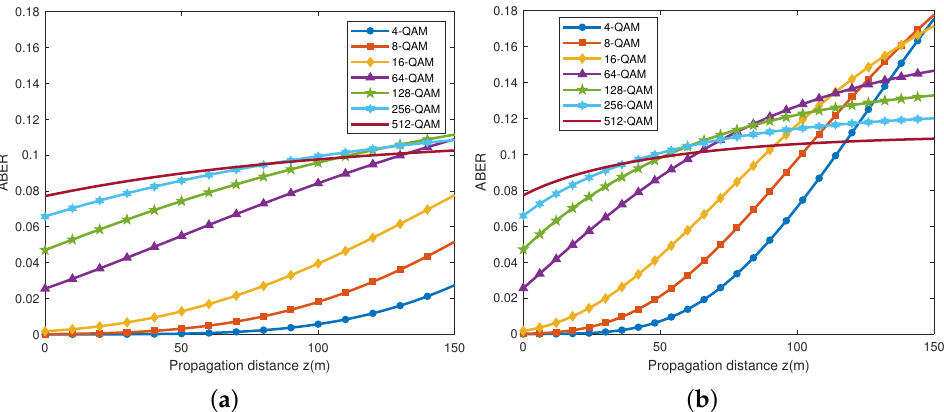
Figure 4. The bandwidth-limited ABER of the POV carrier link with M-QAM versus the propagation distance in the turbulence strength of ( a ) C 2 εχ